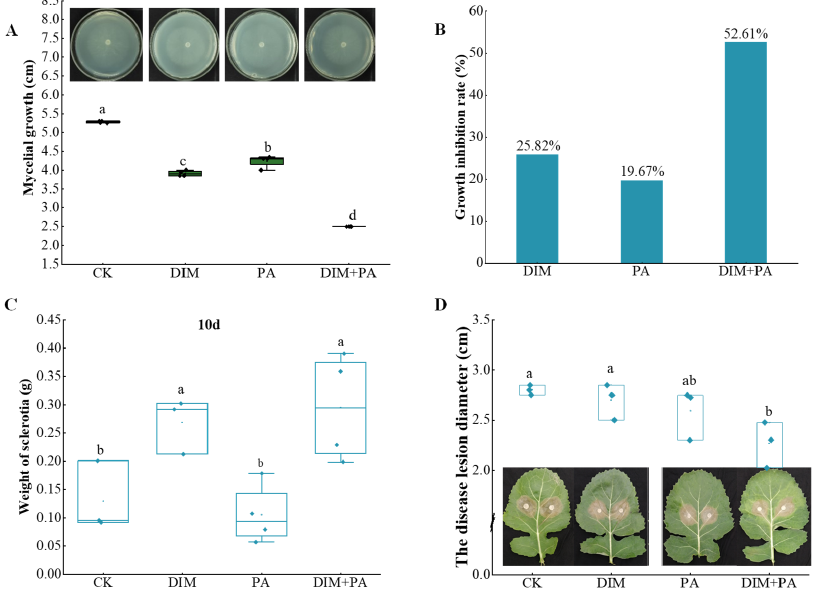
Figure 3. Inhibition of S. sclerotiorum growth by DIM and PA . ( A ) The disease lesion diameter of rape leaves in vitro under treatment. ( B ) Growth-inhibition rate of S. sclerotiorum . ( C ) Effect of DIM and PA on weight of sclerotia after 10 days. ( D ) Effects of DIM and PA on the pathogenicity of rape leaves in vitro. Different letters (a, b, c, d) indicate statistically significant differences among the different treatments ( p < 0.05). The treatments were: CK, DIM (0.8 mg·L − 1 ), PA (0.1 mg·mL − 1 ), and